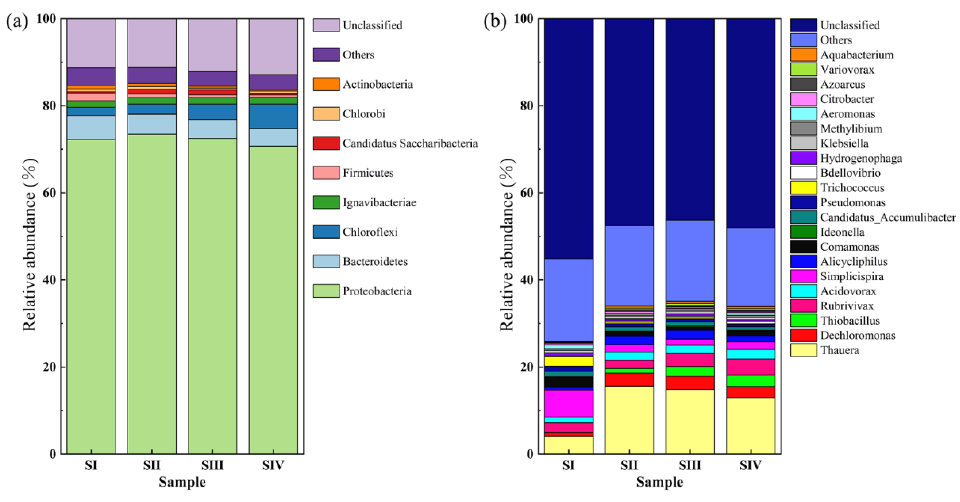
Figure 4. Bacterial community structures at the phylum ( a ), and at the genus level ( b ), during the operation.